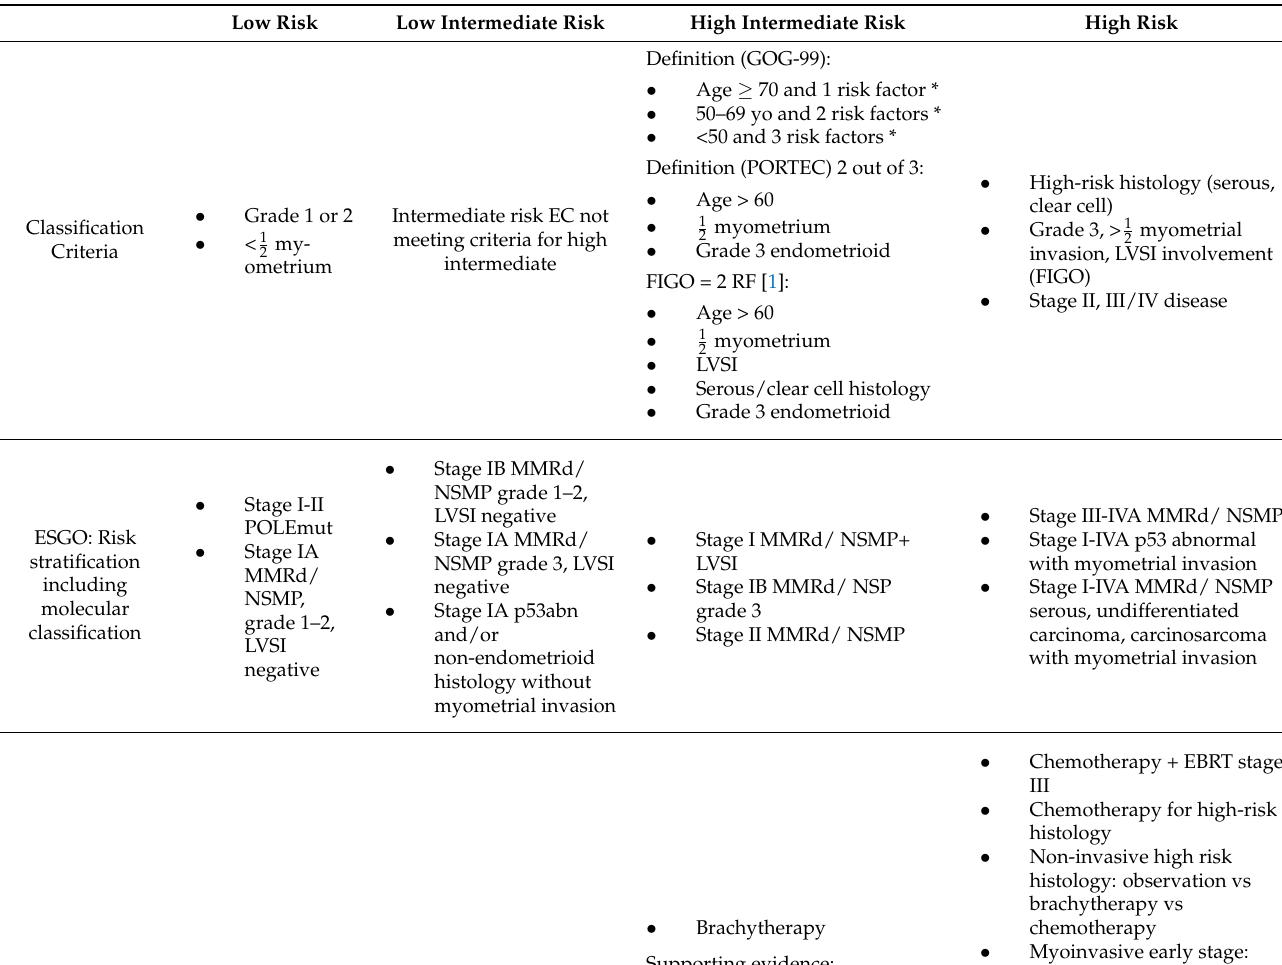
Table 1. Classification of endometrial